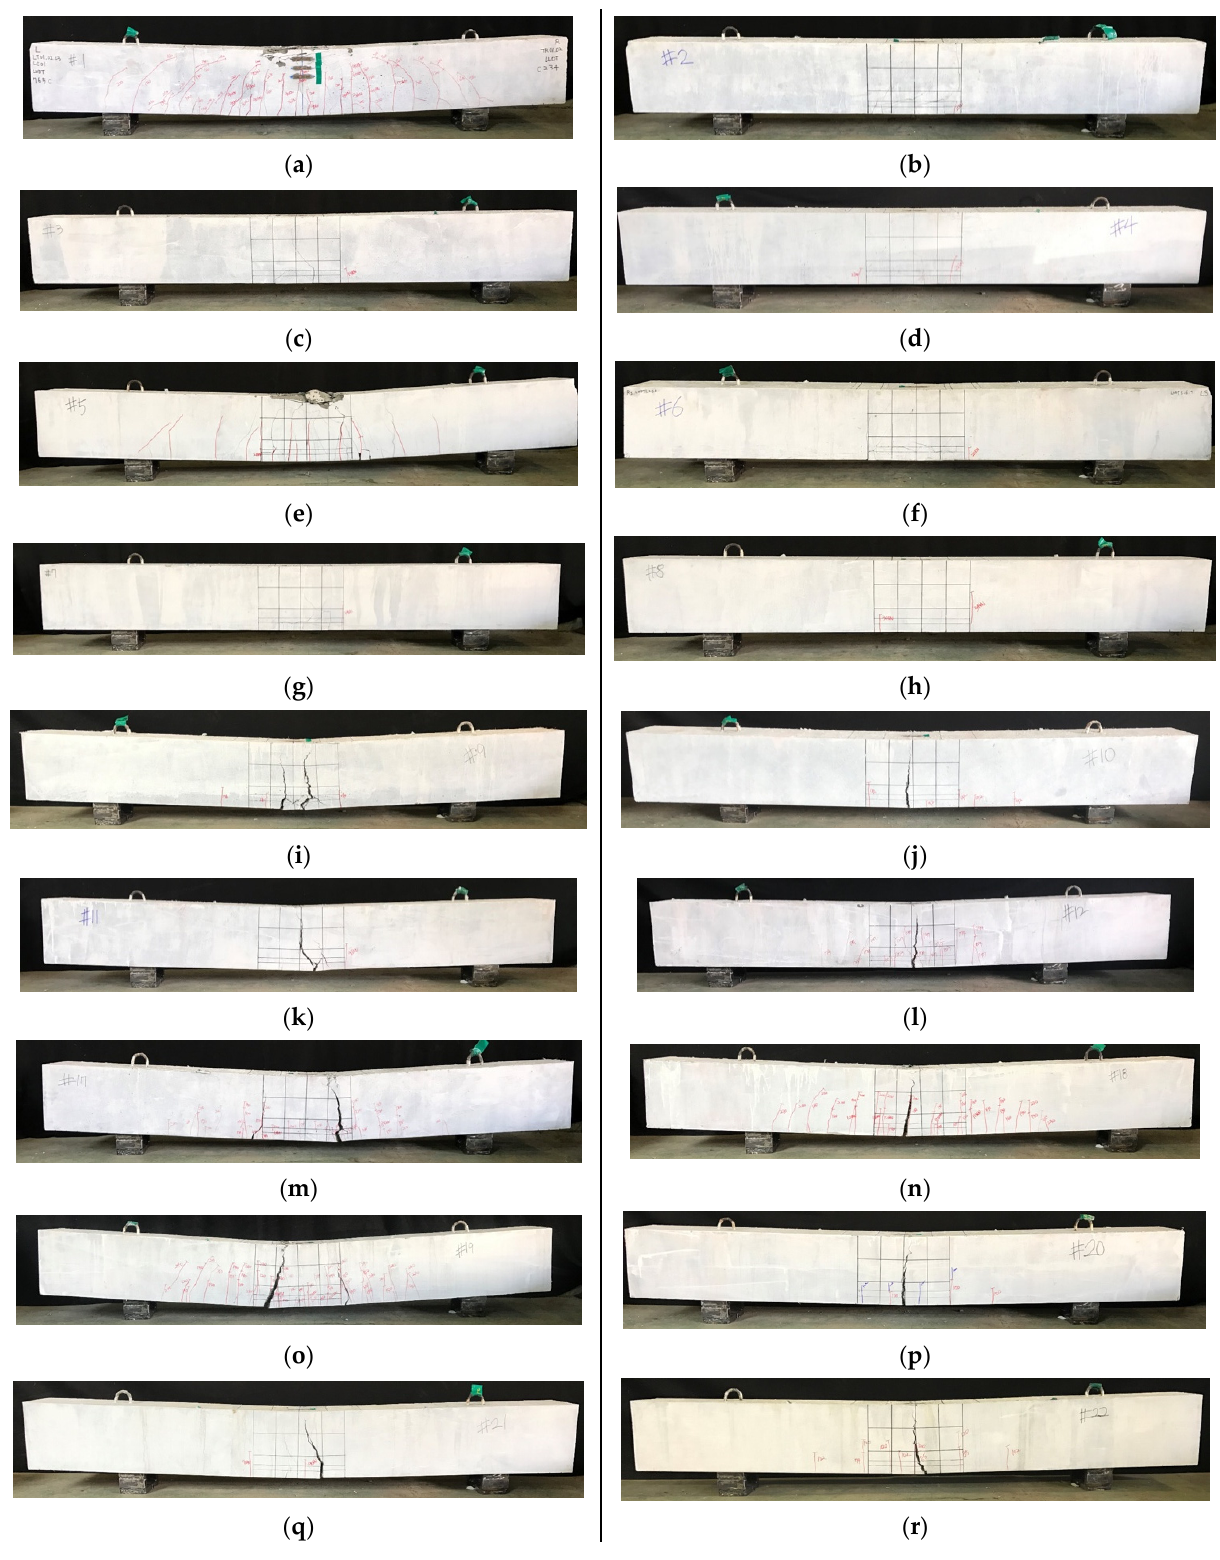
Figure 5. Failure of test specimens: ( a ) 120-0-0; ( b ) 120-15db-0; ( c ) 120-10db-0; ( d ) 120-5db-0; (e) 180-0-0; ( f ) 180-15db-0; ( g ) 180-10db-0; ( h ) 180-5db-0; ( i ) 120-10db-V1.5; ( j ) 120-5db-V1.5; ( k ) 180-10db- V2.0; ( l ) 180-5db-V2.0; ( m ) 120-0-V1.5; ( n ) 180-0-V2.0; ( o ) 180-0-V1.5; ( p ) 180-5db-V1.5; ( q ) 180-10db- V1.0; ( r ) 180-5db-V1.0.